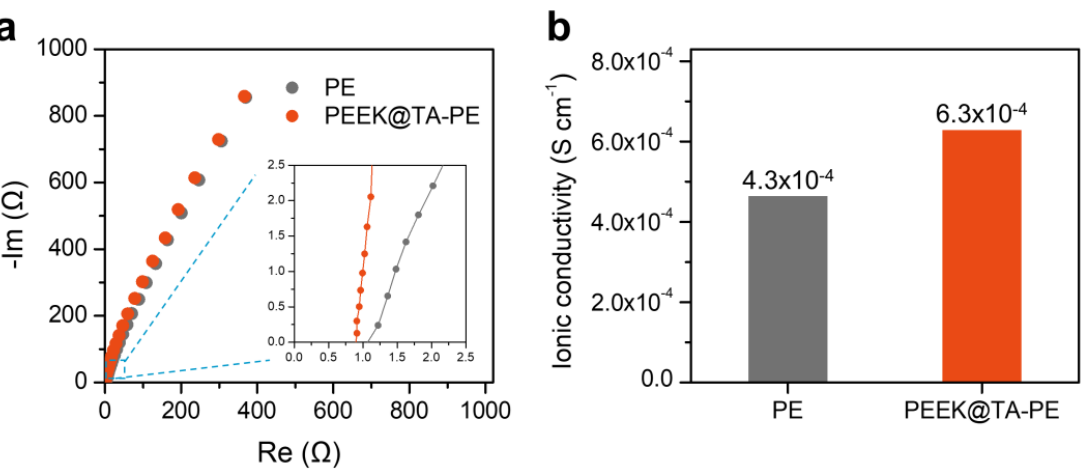
Figure 7. ( a ) Nyquist plots of the SS/separator-electrolyte/SS cells with the PE and PEEK@TA-PE separators; ( b ) calculated ionic conductivity results.